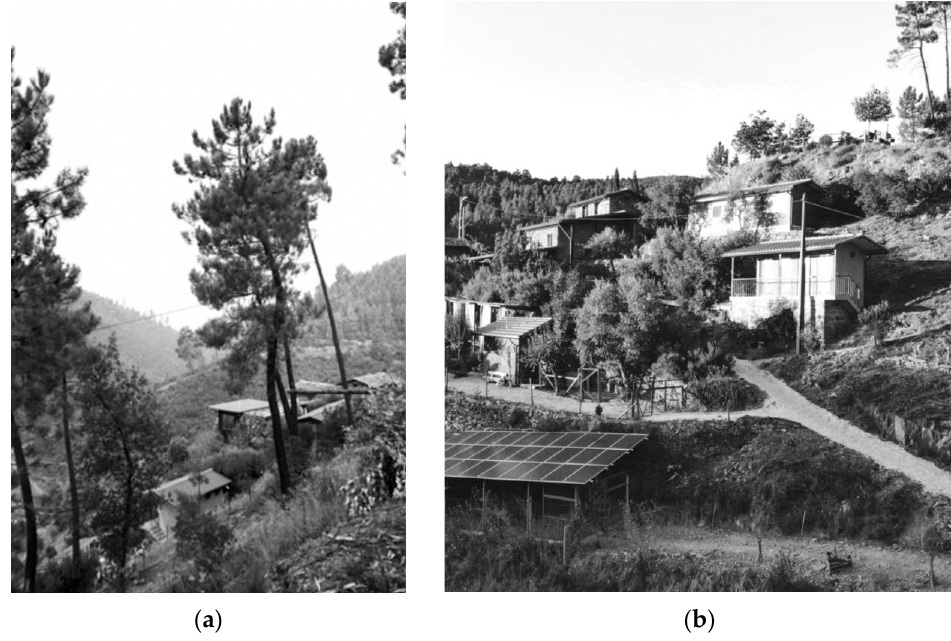
Figure 2. The study area Vale de Moses: ( a ) view from the mountain terrace over the valley; ( b ) existing buildings of the Retreat on the mountain terrace below.